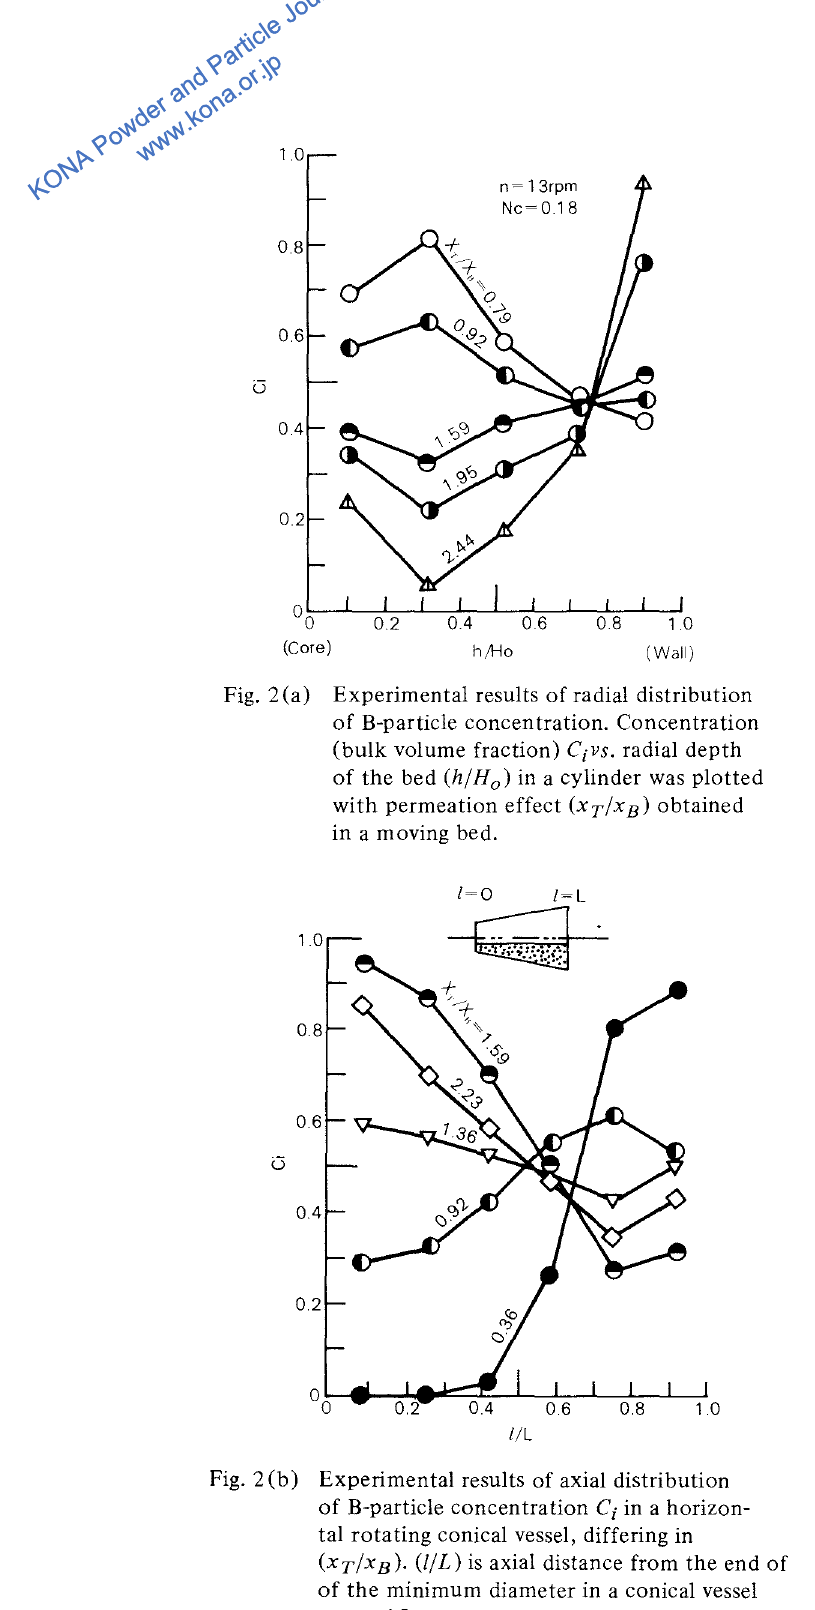
Fig. 2 (b) Experimental results of axial distribution of B-particle concentration Ci in a horizon tal rotating conical vessel, differing in (xrfxB)· (ljL) is axial distance from the end of of the minimum diameter in a conical vessel at n = 15